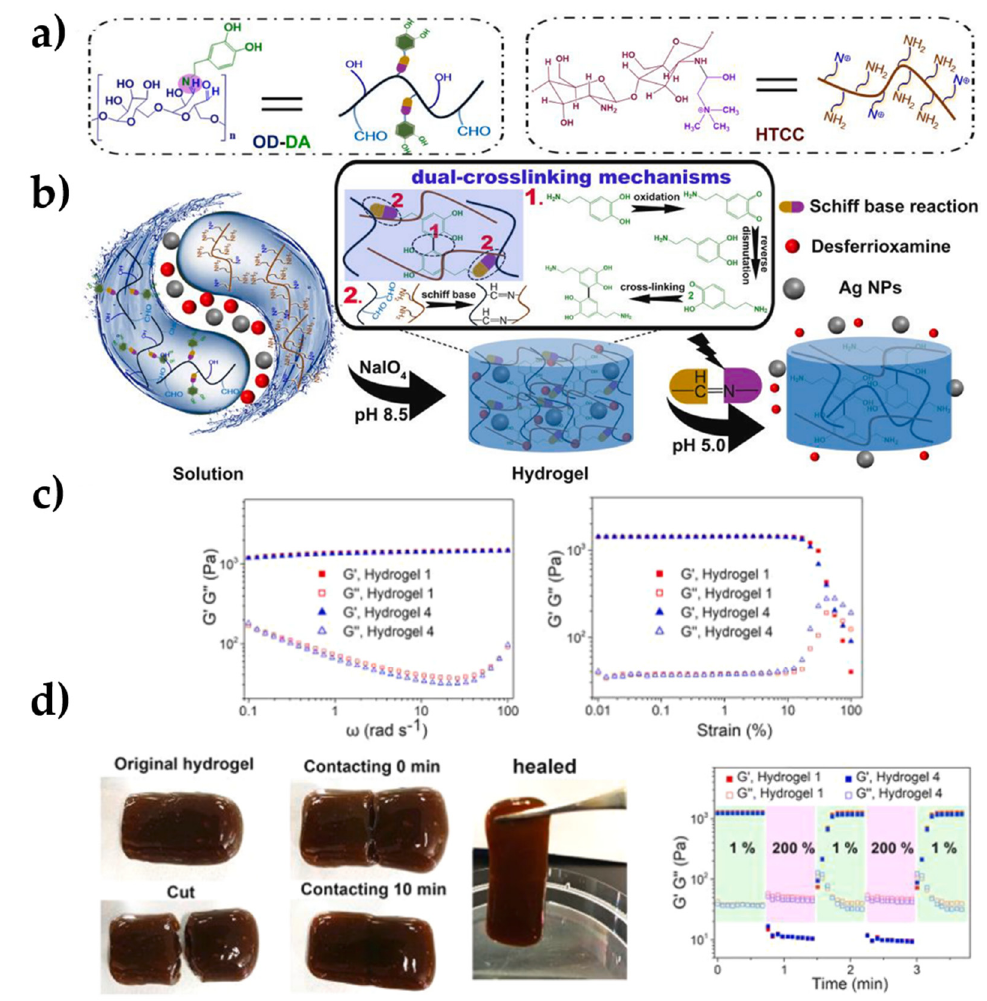
Figure 4. Chemical structures of OD − DA and HTCC: ( a ) schematic representation of the dual- cross − linking mechanism and the cleavage of the Schiff base bonds, followed by the release of DFO and AgNPs; ( b ) G’ and G’’ of the hydrogels as a function of the frequency and the % applied strain; ( c ) self-healing behavior of hydrogel 4 and alternate step strain sweep experiments for hydrogel 1 and hydrogel 4 at strains ranging from 1 to 200% ( d ) Note: Hydrogel 1: control hydrogel, Hydrogel 2: hy- drogel@AgNPs, Hydrogel 3: hydrogel@DFO, Hydrogel 4: hydrogel@AgNPs-DFO. Adapted with permission from